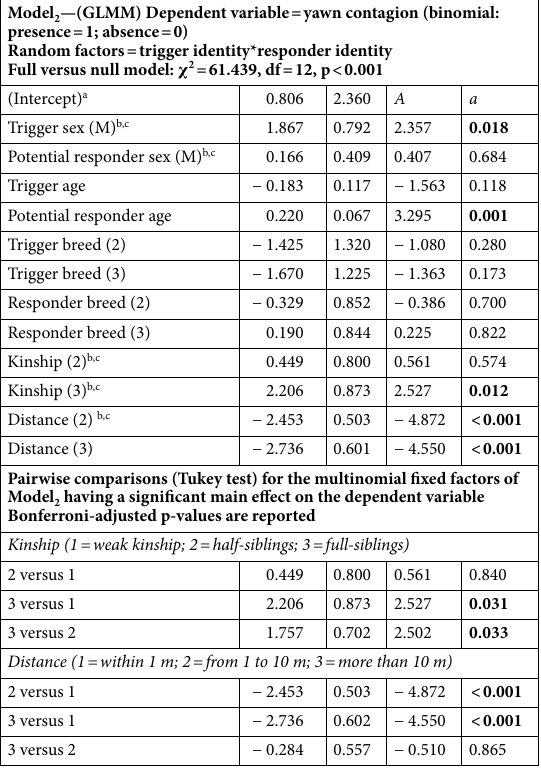
Table 2. Results of Model 2 , testing what individual and social factors can modulate yawn contagion and the pairwise comparisons for the multinomial, fixed factors having a significant main effect on the dependent variable. a Not shown as not having a meaningful interpretation. b Estimate ± SE refer to the difference of the response between the reported level of this categorical predictor and the reference category of the same predictor. c These predictors were dummy coded. For both trigger and potential responder: M = male, F = female; Breed: 1 = Piedmont Black; 2 = Parma Black; 3 = Large White. Kinship: 1 = weak kinship; 2 = half- siblings; 3 = full-siblings; Distance: 1 = within 1 m; 2 = from 1 to 10 m; 3 = more than 10 m.